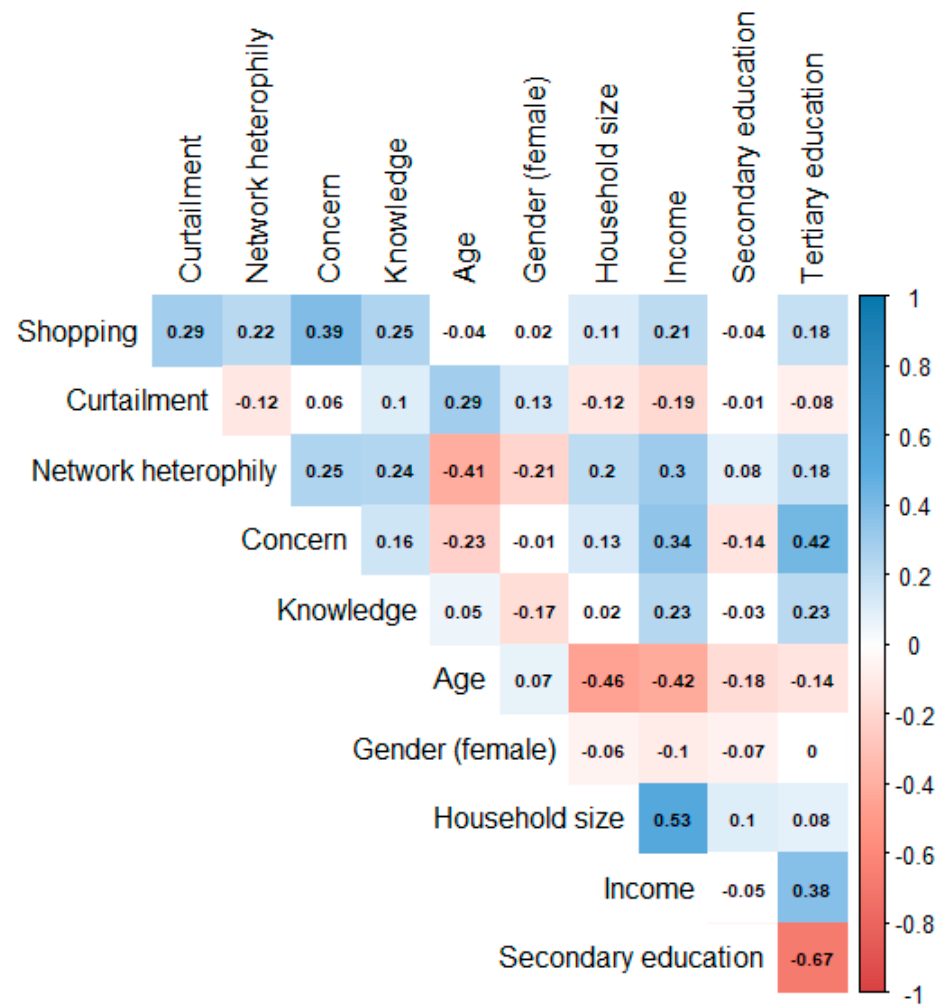
Figure 2. Full covariance matrix: covariances found in the measurement model. Darker cells indicate a stronger relationship between two variables. White cells indicate a non-significant relationship ( p -value > 0.05).